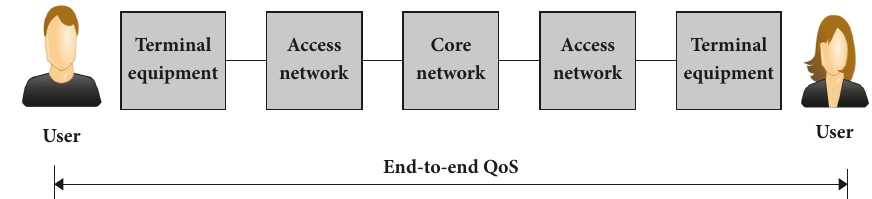
Figure 2: The concept of end-to-end QoS.